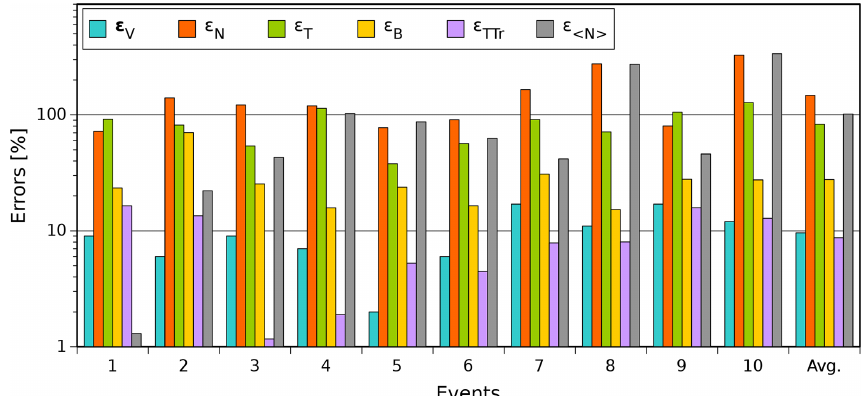
Figure 3. Proportional error histograms associated with our calculated synthetic profiles for speed (cyan), proton density (orange), tempera- ture (green), and magnetic field (yellow). The last set of bars corresponds to the averaged values. Additionally, grey bars are the errors when comparing the median values of proton density ( ε <N> ); and purple ones correspond to the error when comparing the TT r with the transit of the accumulative magnetic field flux’s